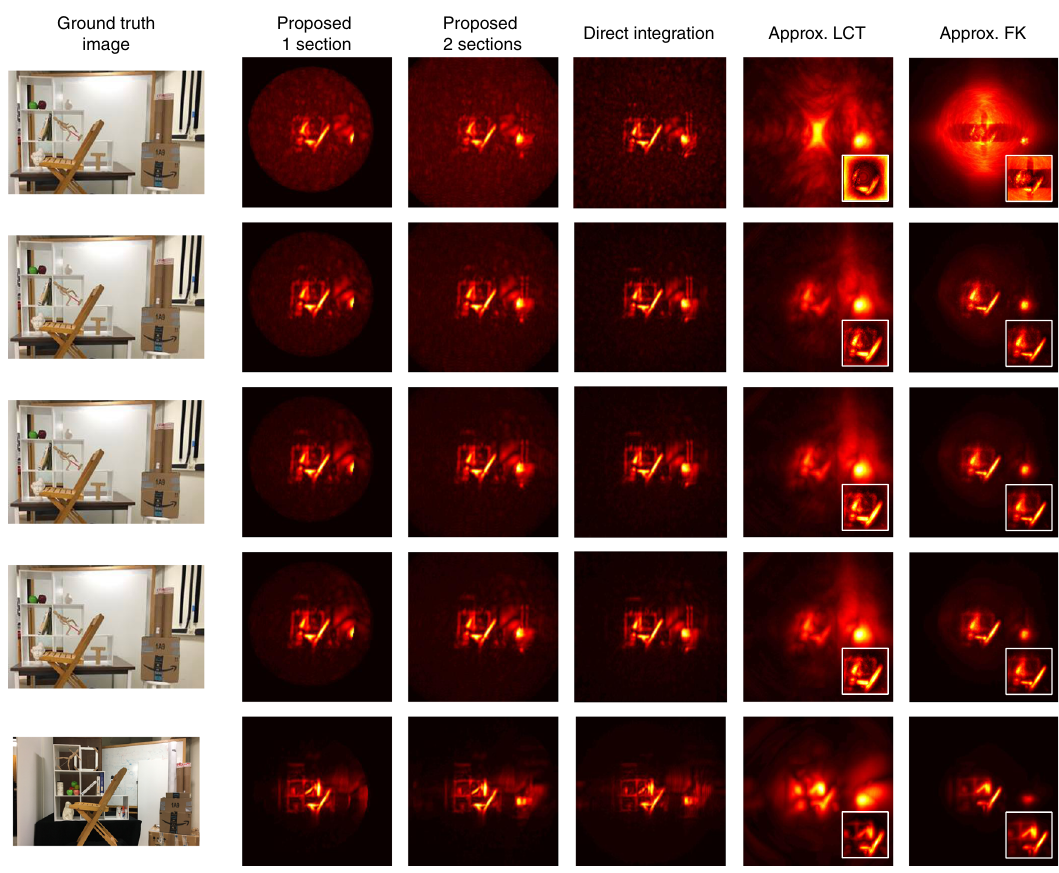
Fig. 7 Methods comparison on Of fi ce Scene: Exposure time per each pixel measurement from fi rst row to last row is 1 ms, 5 ms, 10 ms, 20 ms, 1000 ms (note that the 1000 ms Of fi ce Scene dataset was acquired with slight differences in the object location). The total acquisition time from fi rst row to last row is 23 s, 117 s, 4 min, 8 min, 390 min. The width of the reconstruction cube size in each dimension is 3 m as given along with other reconstruction parameters in Supplementary Table 4. Each column shows the reconstruction with different methods. The fi rst two columns stand for our proposed RSD based solver with one or two spatial sections. The circle in the fi rst column is actually the size of the farthest reconstruction plane which is the one with the largest region that is calculated with the same distance shift B 1 . All planes in front of this one have a smaller reconstruction area; due to the maximum operation along the depth dimension, the circle size is de fi ned by the largest one in the back. The third column is the Direct Integration (back- projection solver) as a comparison for the fi rst two columns. The last two columns refer to the approximation method 9 which approximate non-confocal by confocal data and solve it through the scanning-based solver (LCT: forth column, FK-migration: fi fth column). For the last two columns, each small image shows the results from midpoint approximation 9 in order to approximate confocal data from non-confocal measurements. The respective larger image results from zero-padding applied to the input data to show the same reconstruction volume as the fi rst three